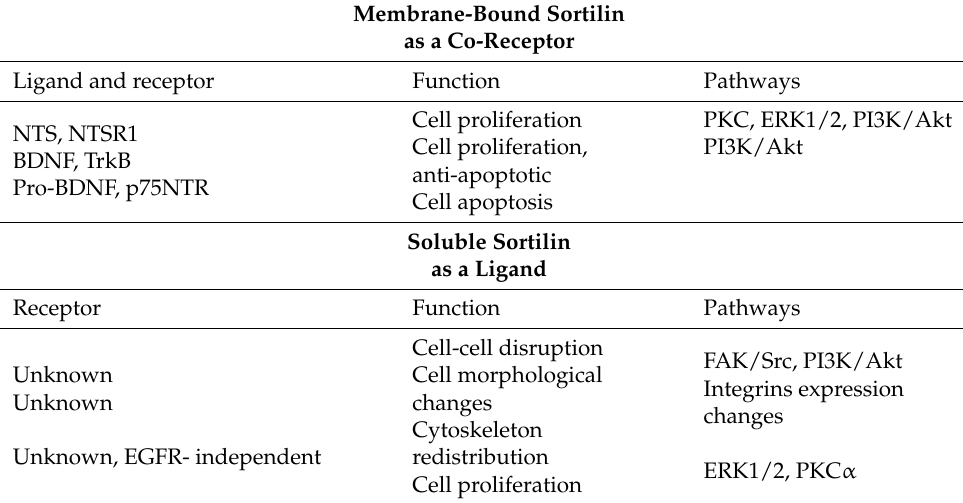
Table 1. Implication of membrane-bound and soluble Sortilin/NTSR3 in CRC